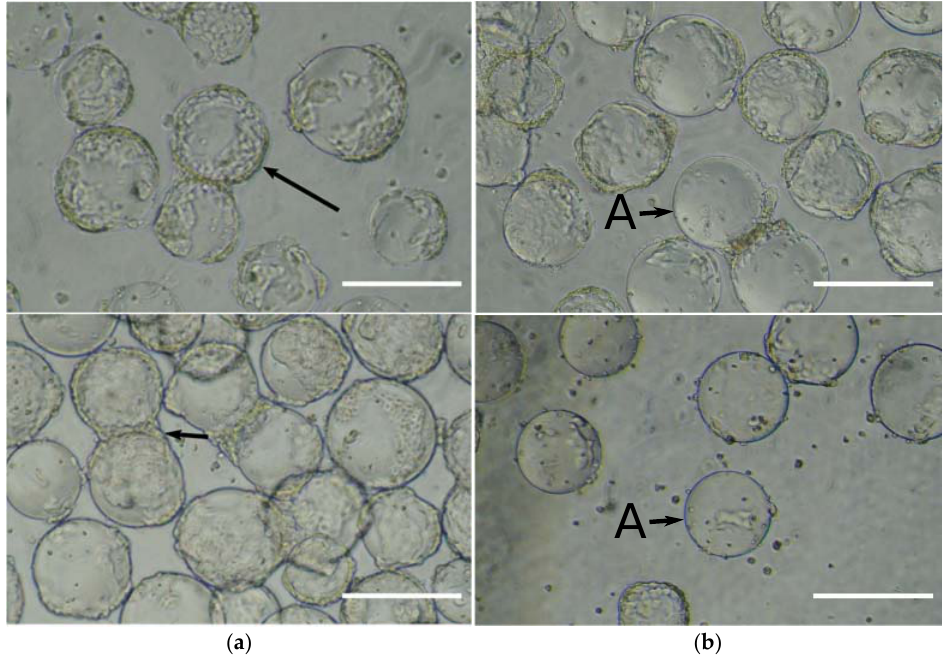
Figure 2. Determination of the maximum shear limit for HEK293T cells attached to Cytodex 3 microcarriers for the bioreactor system DASBox with dual marine impellers—experiment performed in duplicate: reactor 1 (row 1) and reactor 2 (row 2); the scale bar represents 200 µm. The microcar- riers were inoculated at 150 RPM; 24 h after inoculation, the impeller speed was slowly increased from 150 RPM to 400 RPM in steps of 50 RPM intervals. Images of the microcarriers are shown for (( a )—left column) 250 RPM where the cells were attached to the microcarriers, and (( b )—right col- umn) 300 RPM where cell detachment from the microcarriers was observed. The unlabeled arrows represent cells well attached to microcarriers and the arrows labeled with A represent microcarriers where the cells have been sheared off by the hydrodynamic forces. To make a detailed comparison between the spinner flasks and the DASBox; key hy- drodynamic parameters were calculated for each vessel. The most important of these pa- rameters is the Kolmogorov eddy length shown in Equation (2). 𝜎 = (cid:4678)𝜀 × (cid:3436)𝜂 𝜌(cid:3440) (cid:2871) (cid:4679) (cid:2869) (cid:2872) (2) with 𝜎 : eddy size (m), ε : energy dissipation per mass (W kg − 1 ), 𝜂 : dynamic viscosity of the fluid (Pa s), 𝜌 : density of the fluid (kg m − 3 ). Equation (2) requires the energy dissipation per mass, which can be calculated by Equation (3). 𝜀 = 𝑁𝑒 × 𝑁 (cid:2871) × 𝐷 (cid:2873) 𝑉 (3) with 𝑁𝑒 : dimensionless Newton number for the impeller (–), 𝑁 : rotational frequency ( s − 1 ), 𝐷 : impeller diameter (m), 𝑉 : reactor volume (m 3 ). The Newton number, 𝑁𝑒 , was calculated for the spinner flask at agitation rates 50 RPM and 70 RPM using the Nagata correlation [21], see Table 1. The Newton number for the DASBox bioreactor was assumed to be identical to the value for a marine impeller as given in [22], also listed in Table 1. Table 1. Newton numbers for the Bellco spinner flask and the DASBox bioreactor. Spinner Flask 50 RPM